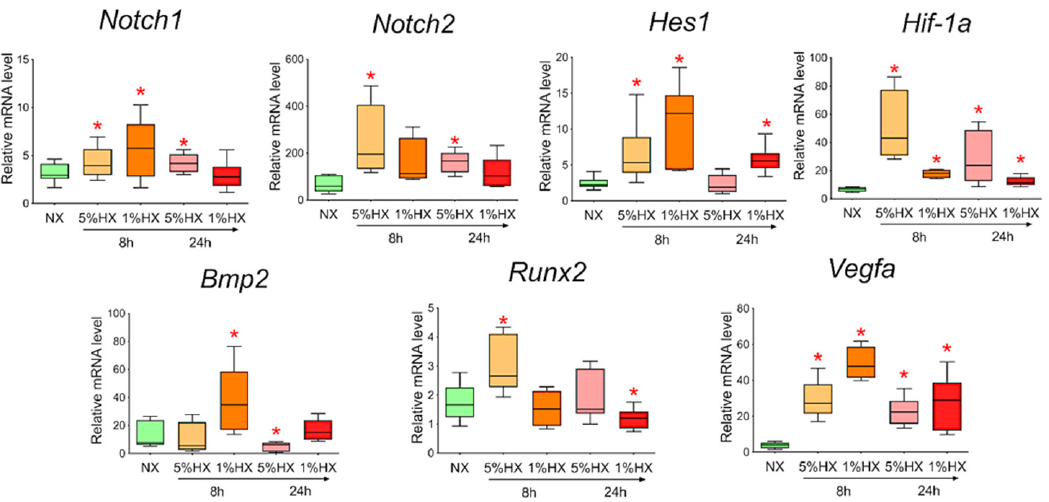
Figure 8. Dynamics of expression of Notch signaling pathway components, Bmp2/Runx2 factors, and hypoxic stress markers in cardiac mesenchymal cells obtained from healthy myocardium of sham-operated rats by quantitative PCR analysis. NX—healthy cells in a state of normoxia ( n = 3); 5% HX—healthy cells in a state of hypoxia with an oxygen level of 5% ( n = 3); 1% HX—healthy cells in a state of hypoxia with an oxygen level of 1% ( n = 3). Horizontal—the time at which the cells were in hypoxic conditions. Vertical—the relative amount of mRNA, measured by the 2 - ∆∆ CT method; box plots with whiskers at min to the max are presented. * The asterisk shows significant differences between the control and the 5% HX and 1% HX groups at p < 0.05 (unpaired